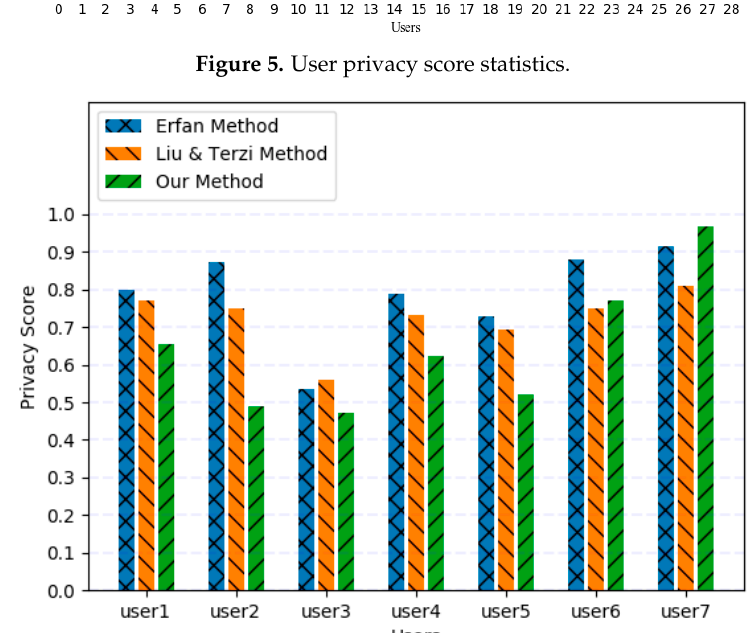
Figure 6. Experiment 2 privacy score.